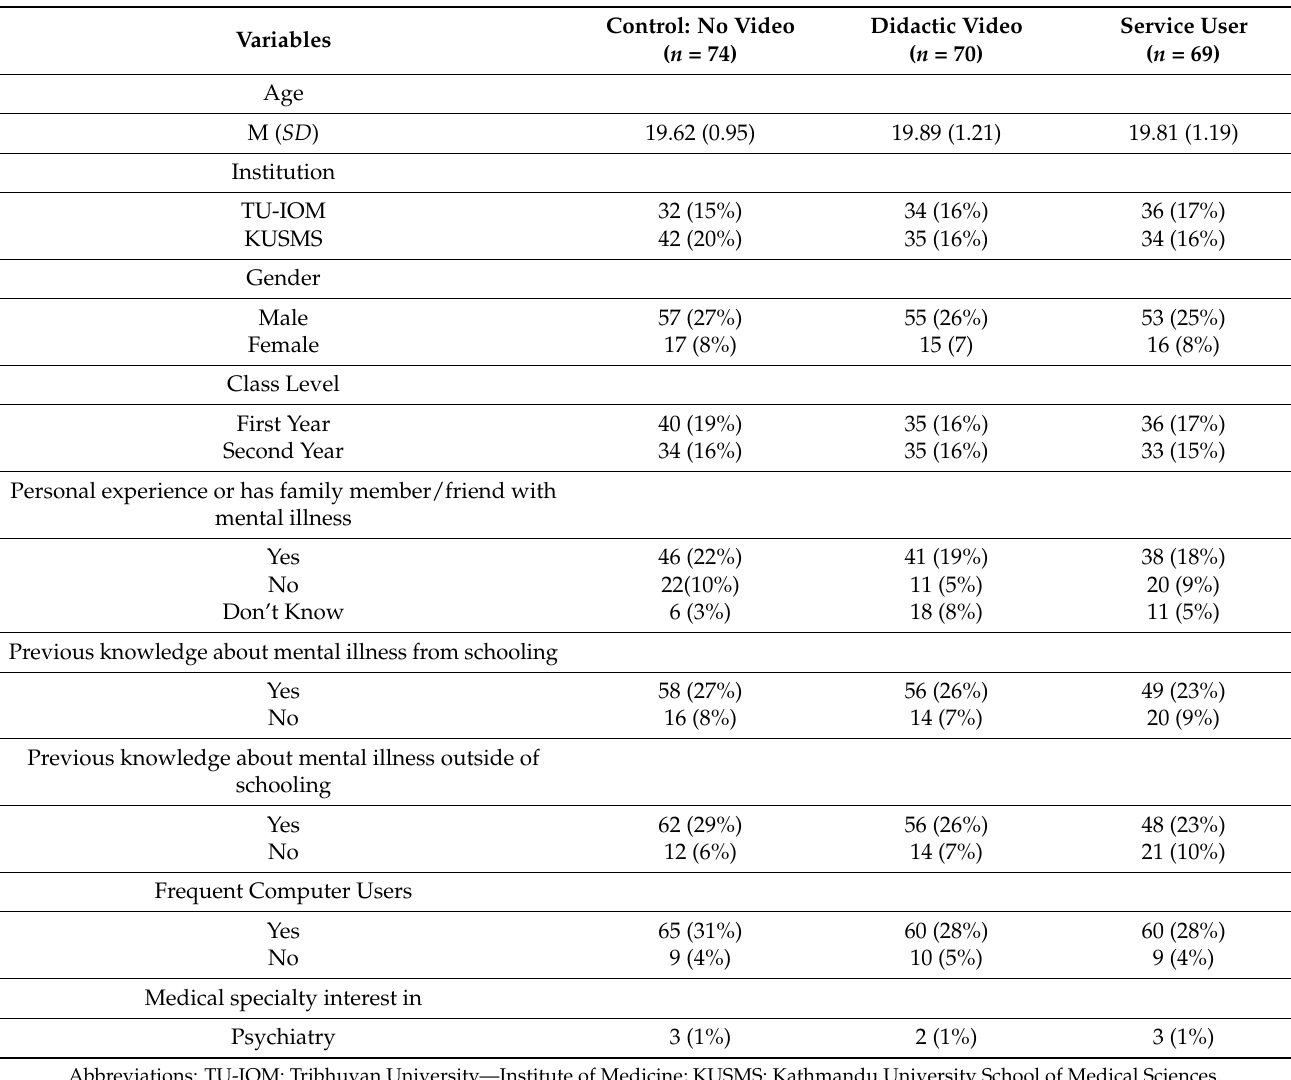
Table 4. Study 2 (depression and psychosis) participant demographic characteristics in each study condition ( n =